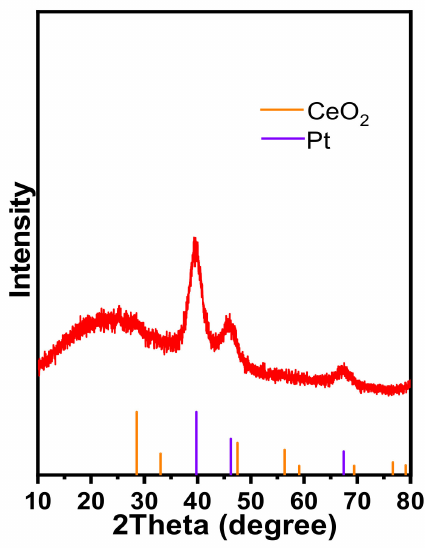
Figure 8. XRD pattern of Pt/CeO 2 -NS-NA.